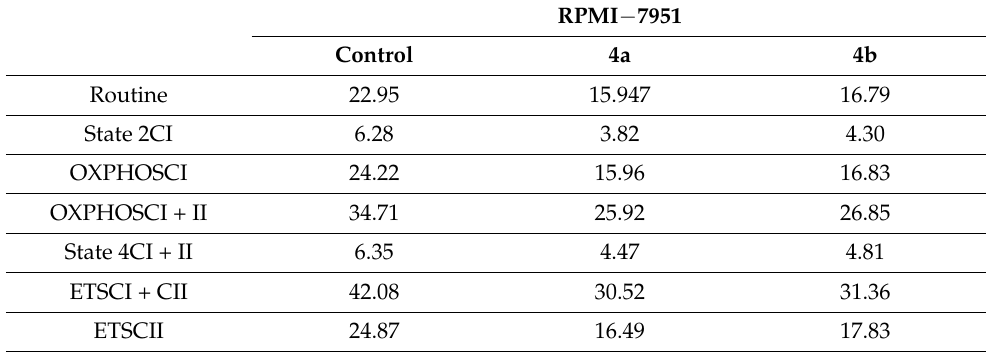
Figure 8. The rates of mitochondrial respiration in permeabilized RPMI−7951 cells after treatment with compounds 4a and 4b (tested at IC 50 : 18.8 μM and IC 50 : 20.7 μM, respectively) for 48 h. All experiments were repeated five times and the results are reported as mean values ± S D. One−way ANOVA followed by Bonferroni’s post−test were used in order to identify statistical differences vs.